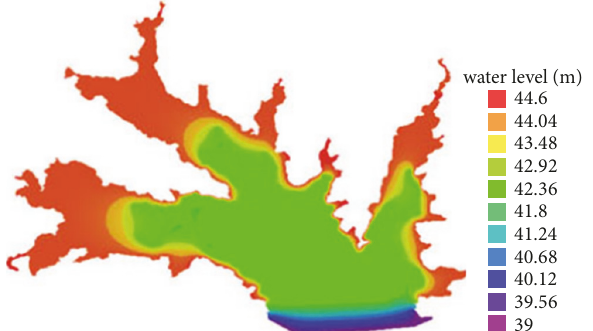
Figure 7: Groundwater contours with a reservoir water level of 42.5